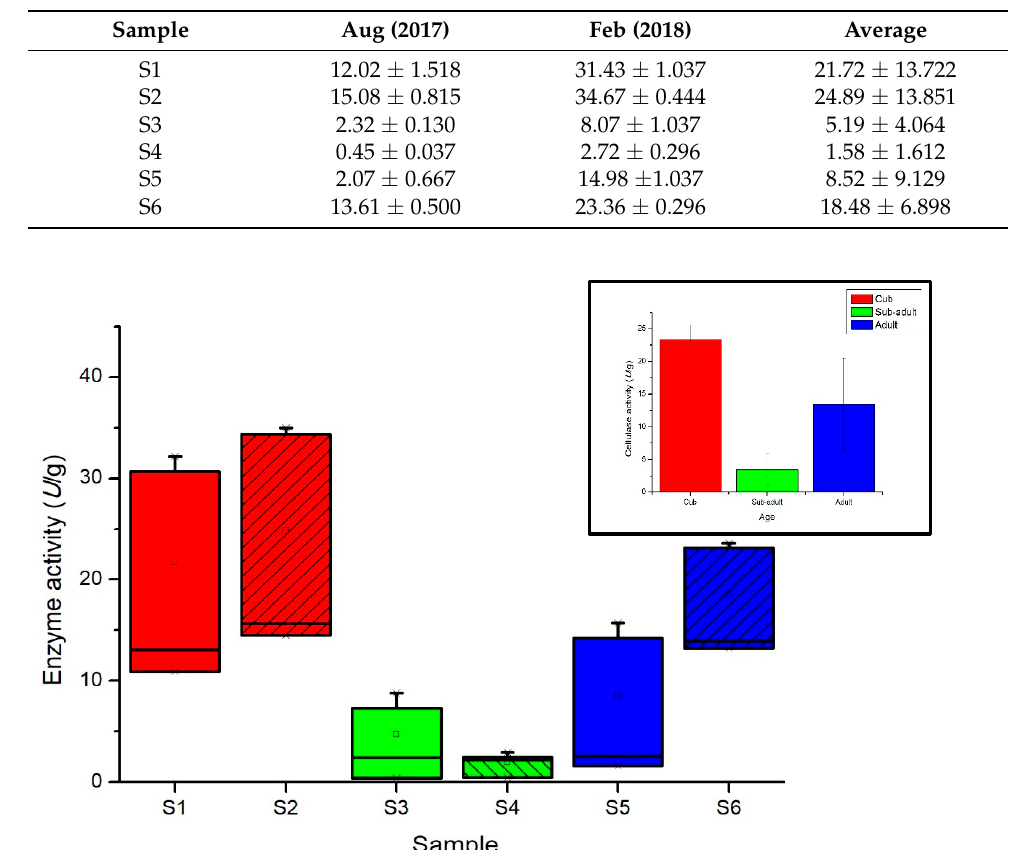
Table 2. Intestine cellulase activity of giant panda at different developmental stages.